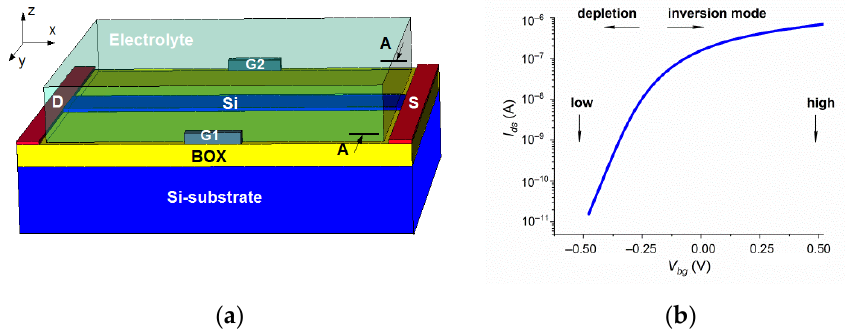
Figure 1. ( a ) Simulated n-channel SOI-FET sensor; ( b ) typical I ds (V bg ) dependence of sensors. The sensor thickness, width, and length were 30 nm, 500 nm, and 3 µm, respectively. The buried oxide (BOX) thickness was 200 nm. The acceptor concentration in the sensor element was 10 16 cm − 3 . The donor concentration was 10 20 cm − 3 in the contact regions of the drain (D) and source (S) at the ends of the sensor element.